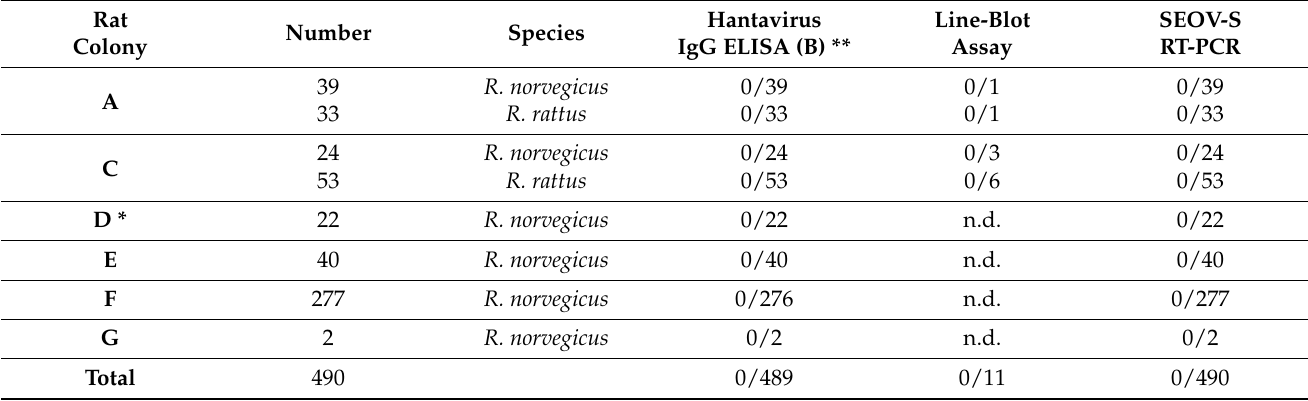
Table 2. Results of serological and conventional RT-PCR analyses of different breeding colonies with wild rats or laboratory rats in Germany.